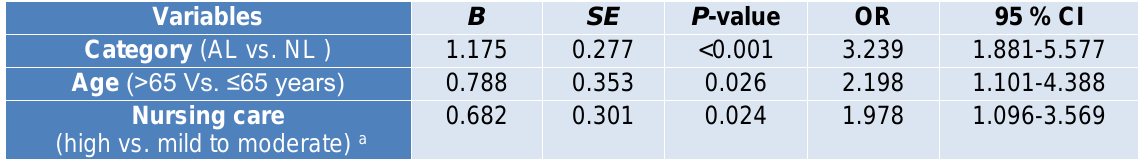
Table 4: Backward logistic regression analysis of influencing factors to predict delirium recurrence in patients with delirium at the admission time